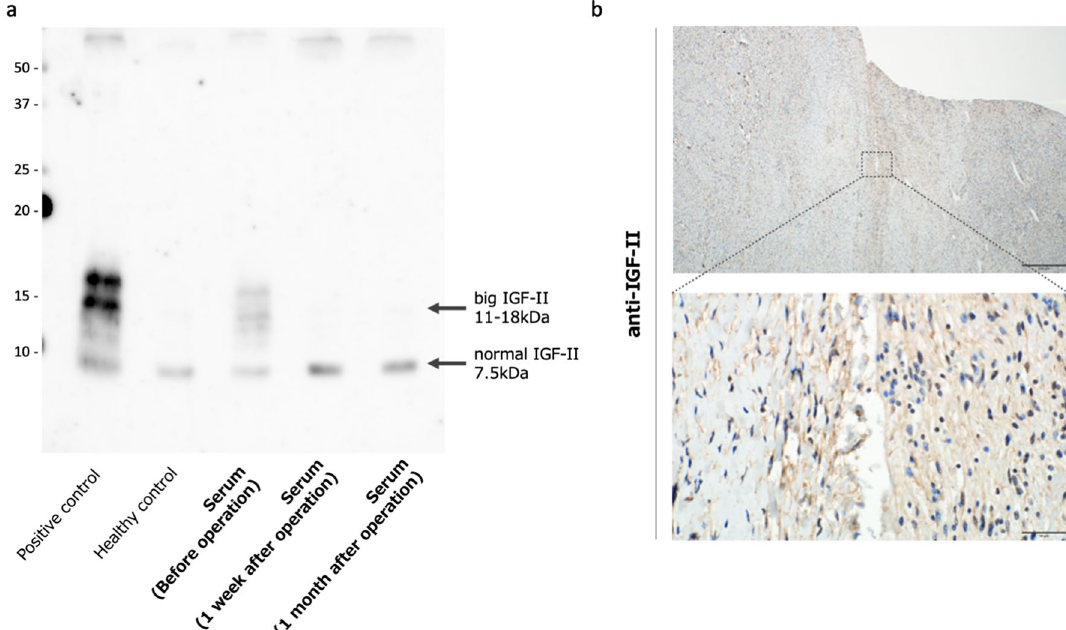
Fig. 4 Western blot images showed that migrated bands were seen around 15 kDa (big IGF-II) in the serum sample before operation and disappeared after operation ( a ). Immunohistochemistry showed cytoplasm of the tumor cells was stained by IGF-II ( b